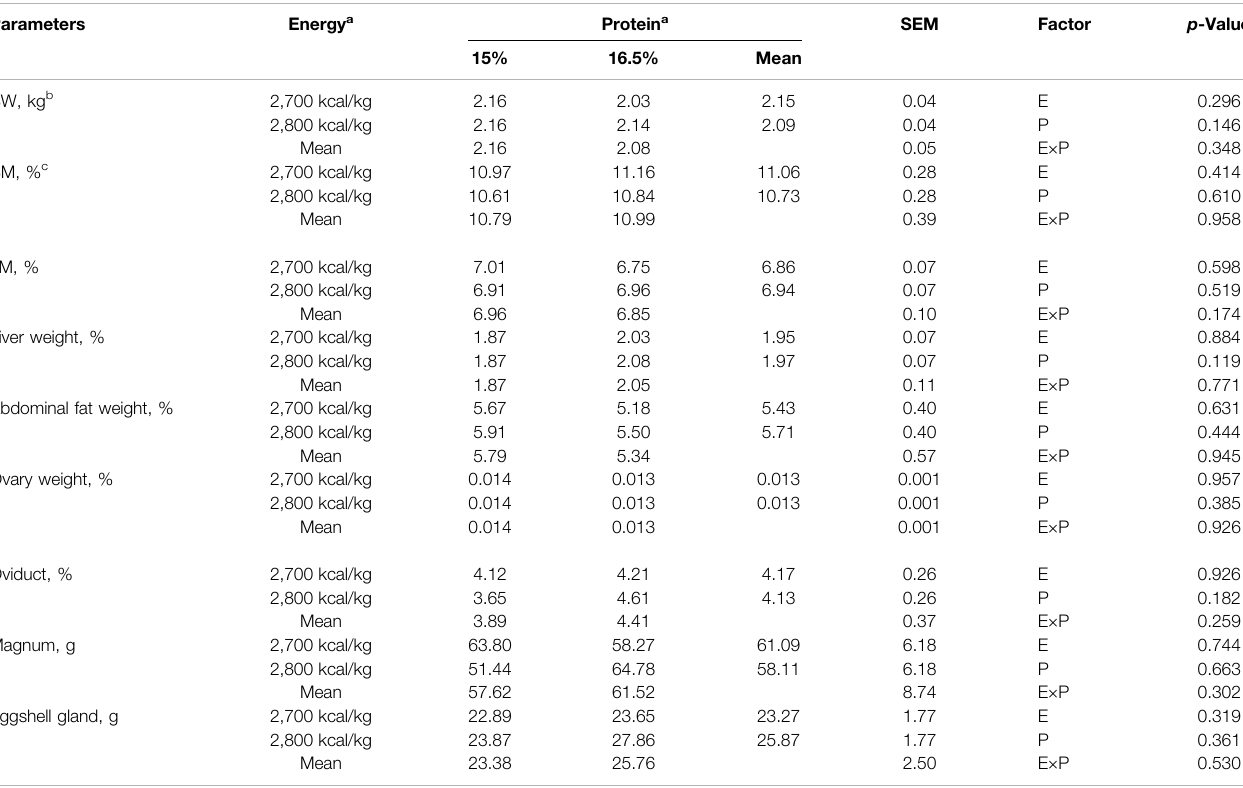
TABLE 5 | Effect of dietary metabolizable energy (E) and crude protein (P) levels during the prelay period (15 – 20 weeks of age) on body weight, relative muscle and organ weight of laying hens at 72 wk of age. Parameters